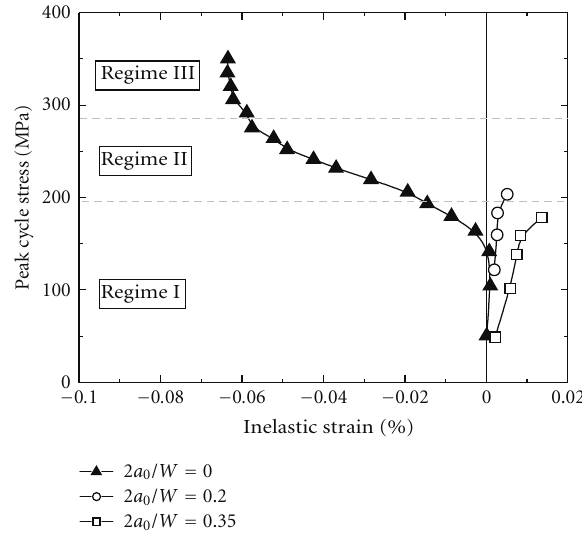
F 6: Inelastic strain plotted as a function of cycle stress for different notch